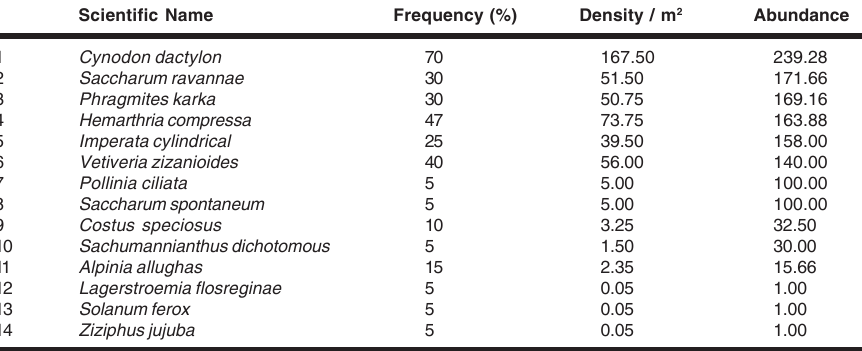
Table 3. Distribution status of terrestrial grasses and trees consumed as food by rhinos in Pobitora Wildlife Sanctuary